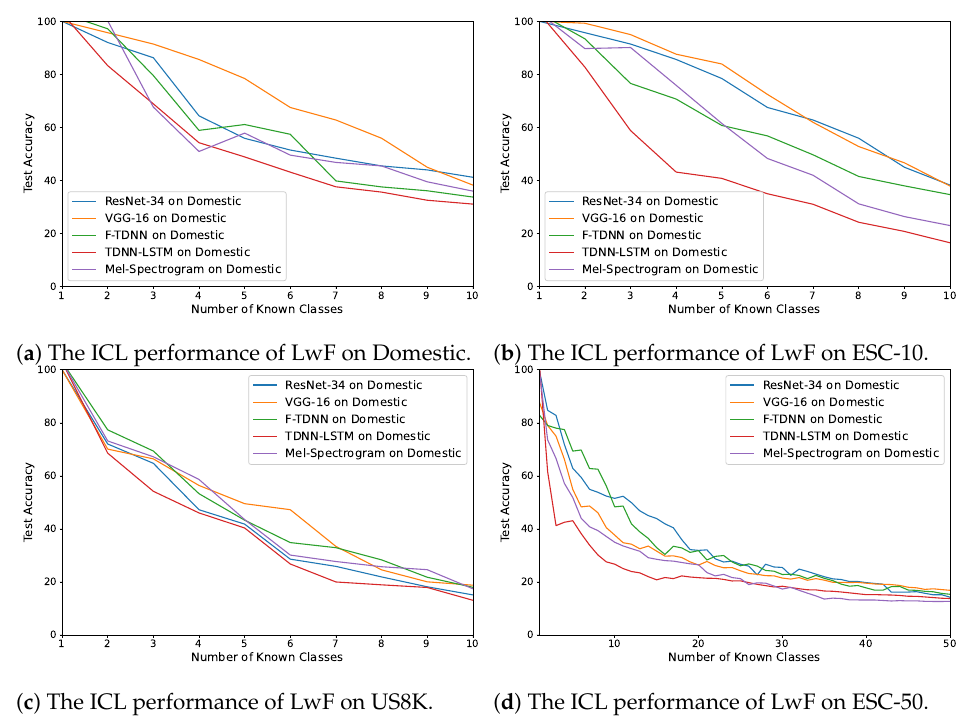
Figure 4. The average accuracy changes while incrementally learning new classes by LwF on the datasets: ( a ) Domestic, ( b ) ESC-10, ( c ) US8K, and ( d ) ESC-50.